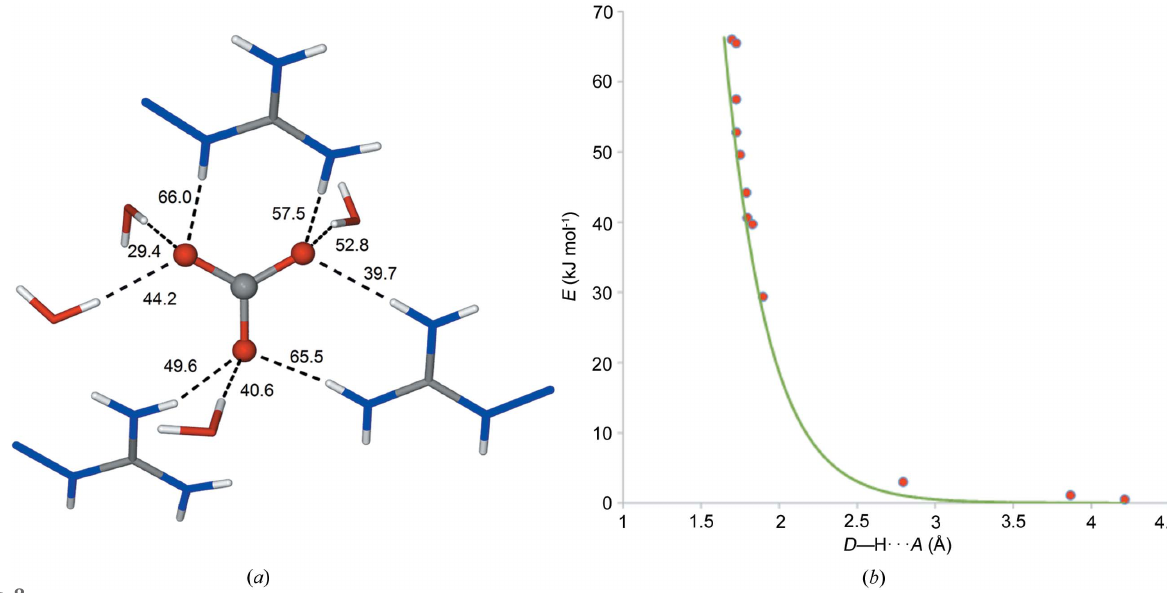
Figure 8 Hydrogen bonding involving the carbonate anion. ( a ) Carbonate ‘binding’ by five guanidinium and four water hydrogen bonds, with estimated dissociation energies in kJ mol (cid:2) 1 . ( b ) Observed correlation between hydrogen-bond energies and H (cid:8)(cid:8)(cid:8) O contact distances; red points are from our experiment and the green line is from the work by Espinosa et al.